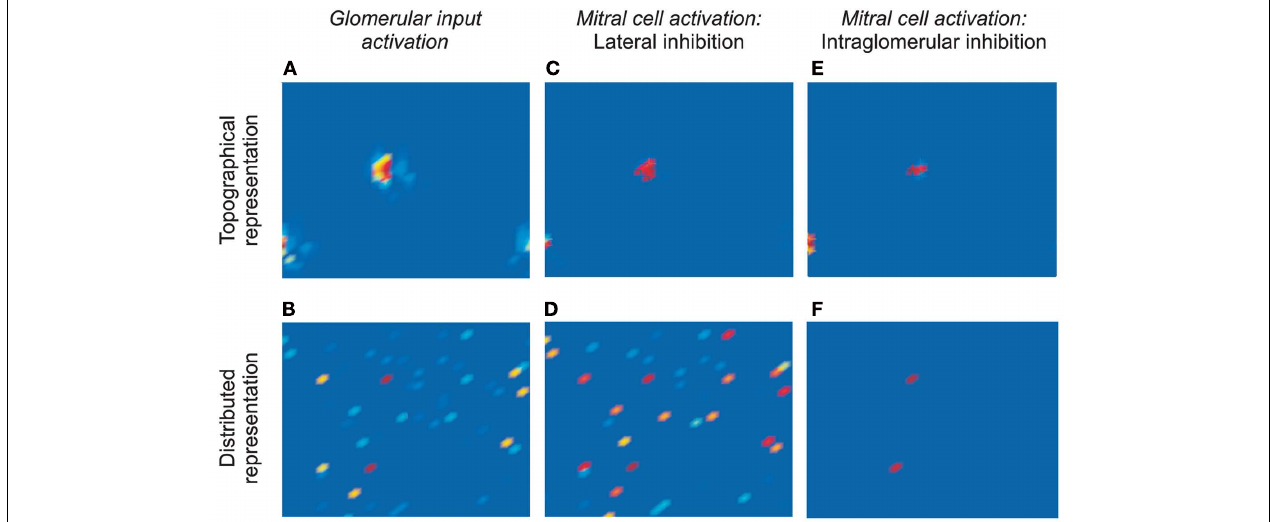
FIGURE 2 | Simulations of odor-evoked activity and the efficacy of decorrelation mechanisms. (A) Response of a 32 × 32 array of glomeruli to presentation of a model odorant, prior to the application of inhibition (corresponds to Figure 1Bii , or to Mi in in Figure 1Ci ).The locations of activated glomeruli were grouped into two clusters according to their levels of activation in order to replicate a retina-like topology of similarity ( topographical representation ; the lower right and lower left sub-clusters are contiguous because the map wraps around). (B) The same response profile as in (A) , except that the locations of activated glomeruli were distributed randomly across the 32 × 32 matrix ( distributed representation ). Note that the deep red-colored glomeruli are the most strongly activated in both representations. (C) Response of the 32 × 32 array of mitral cells in the topographical representation scenario after the effects of lateral inhibition are incorporated.The mitral cell activation profile is sharper and narrower at each of the two clusters, such that only